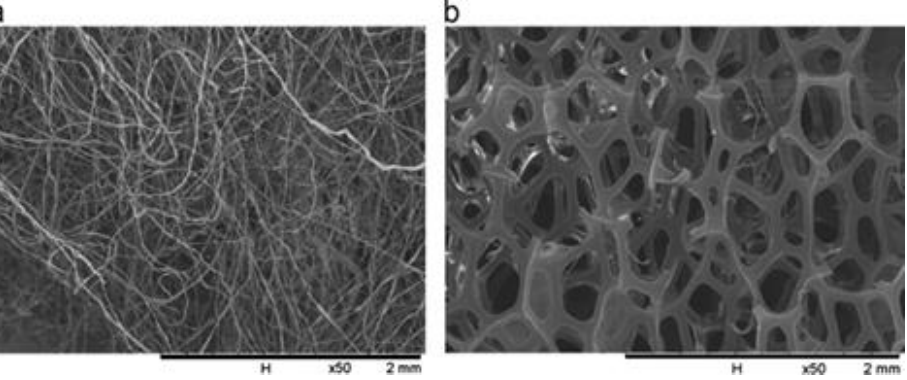
Figure 6. SEM images of the templates: ( a ) cotton and ( b ) sponge. Reprinted with permission from Ref. [79]. Copyright 2014 Elsevier .